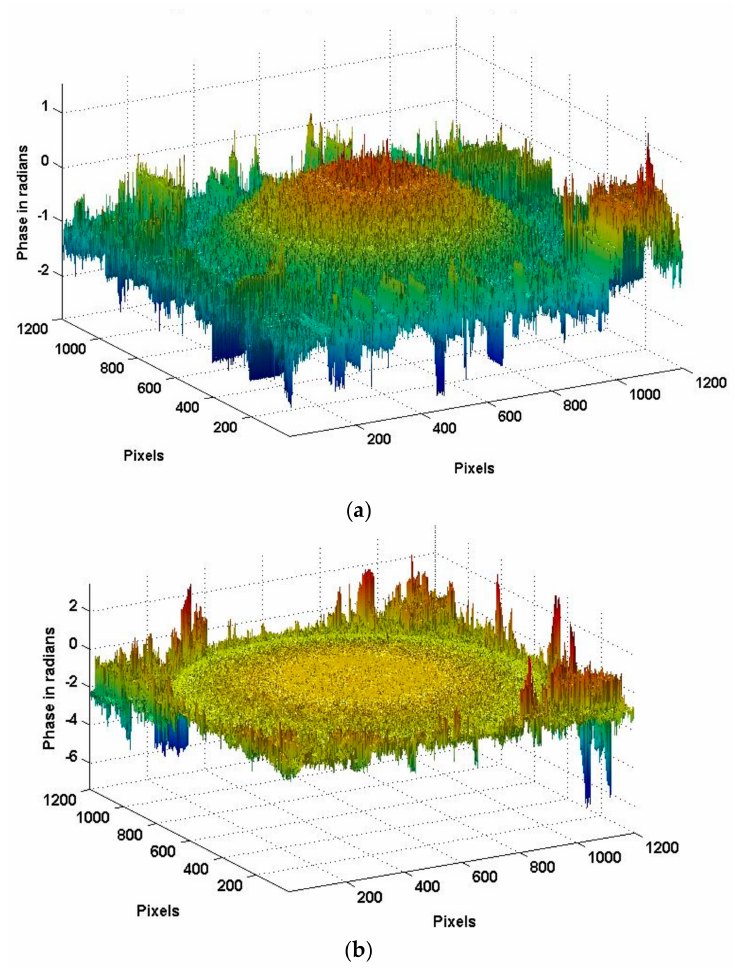
Figure 15. The surface topography at t 1 and t 2 moment. ( a ) Maximum surface topography at t 1 moment; ( b ) the surface topography at t 2